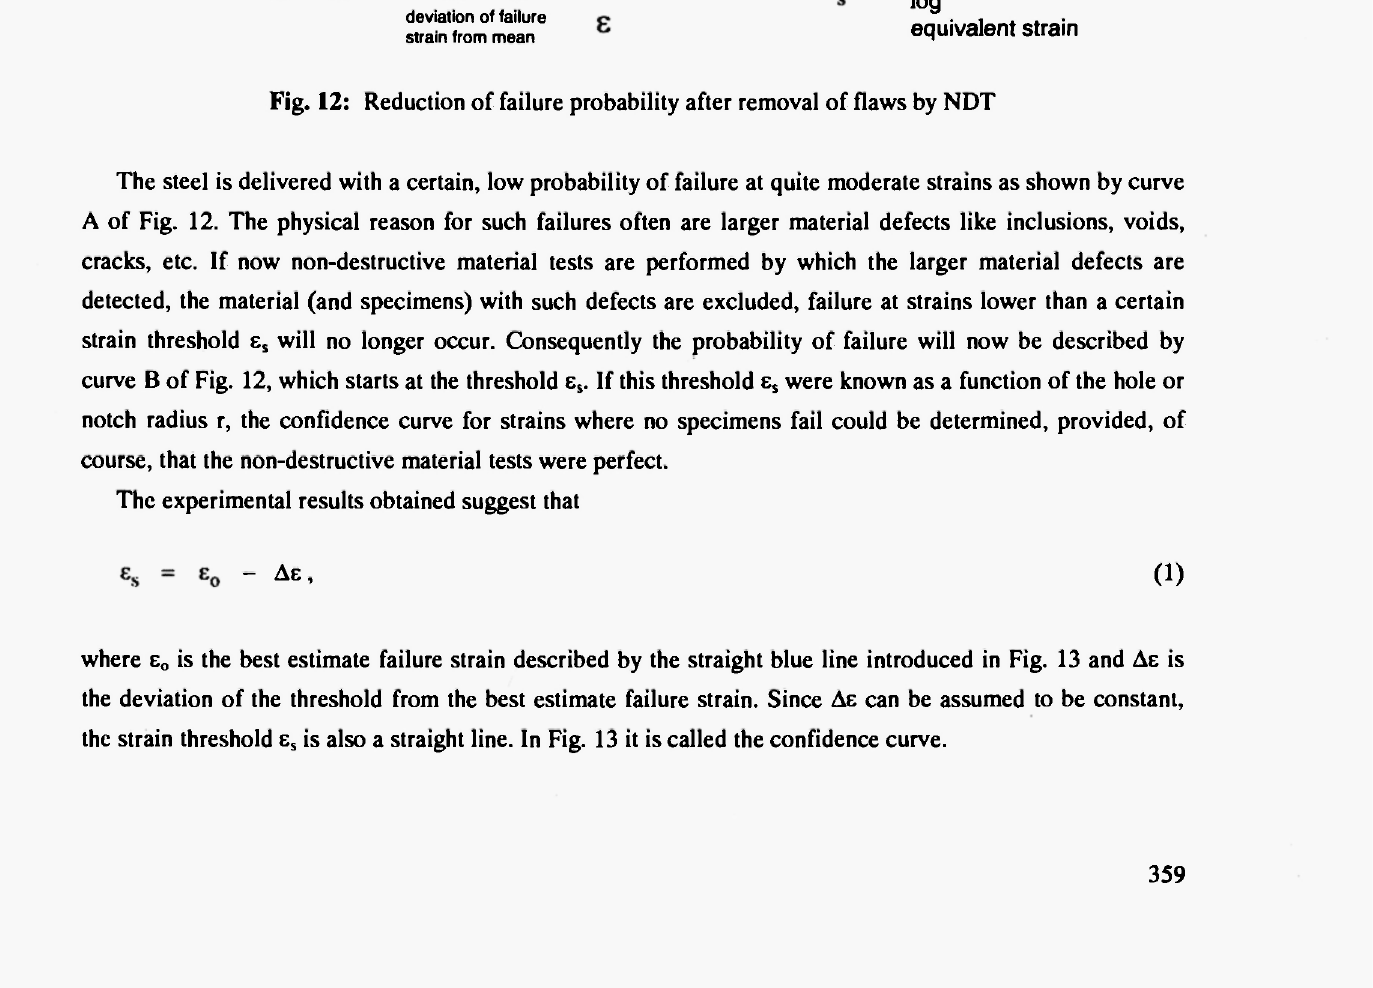
Fig. 12: Reduction of failure probability after removal of flaws by